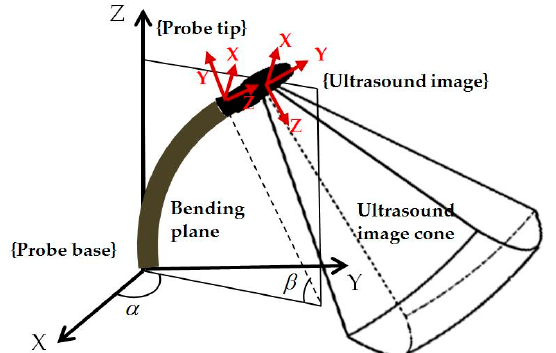
Figure 3. Geometric illustration of the TOE probe tip bending with the coordinates of the probe base, probe tip, and ultrasound image shown. The probe tip coordinate frame is defined on the rigid section of the probe head (based on a nano-CT scan of the probe) and the ultrasound image coordinate frame was defined by a fixed calibration from the probe tip coordinates.